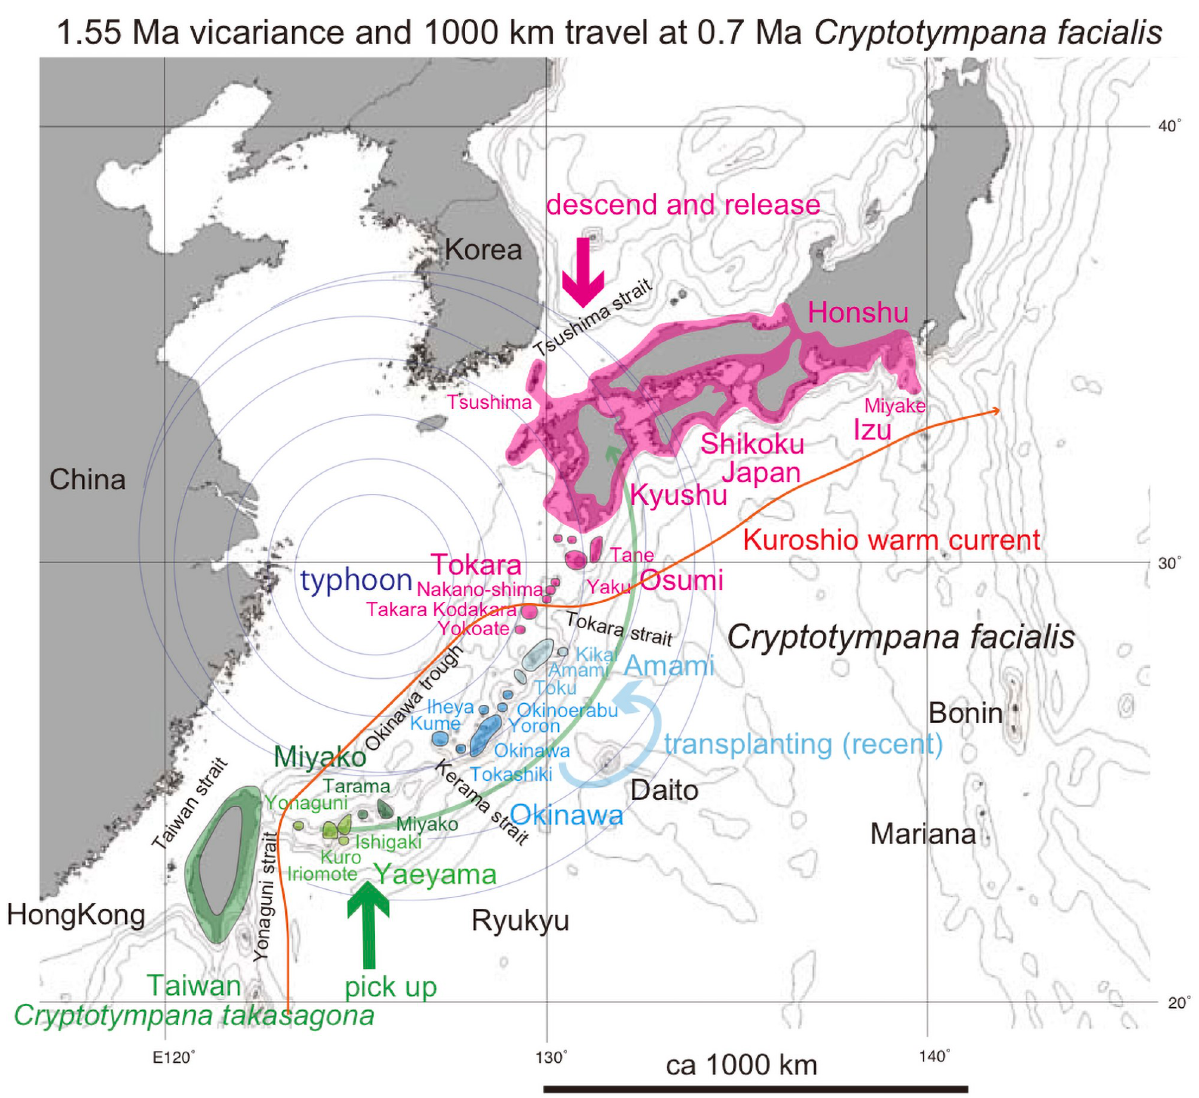
Fig 1. Distribution of Cryptotympana facialis in the Ryukyu and Japanese islands and C . takasagona in Taiwan. These species are lowland species as shown for the Japanese islands. Island populations are shown by color highlights. See Discussion; Green anticlockwise curved track: Super typhoon dispersal from Yaeyama (pale green) to Japan (red). The bold short arrows schematically (not to scale) show where the typhoon winds picked up cicada (green) and where the same cicada were released (red). Recent dispersal by human transport is also shown by the shorter counterclockwise path. The Kuroshio warm current is shown by the thin orange path with the arrow indicating northward to northeastward movement. Base map from Vector Map (VMap) Level 0, National Geospatial-Intelligence Agency.